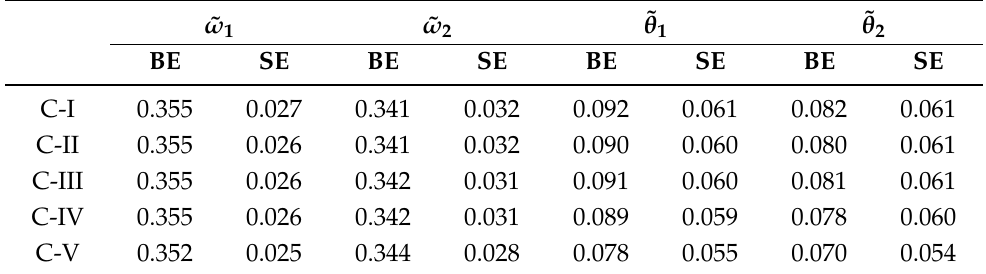
Table 2. The obtained BEs and their standard errors (SEs) via using the proposed 3RR-HB method.